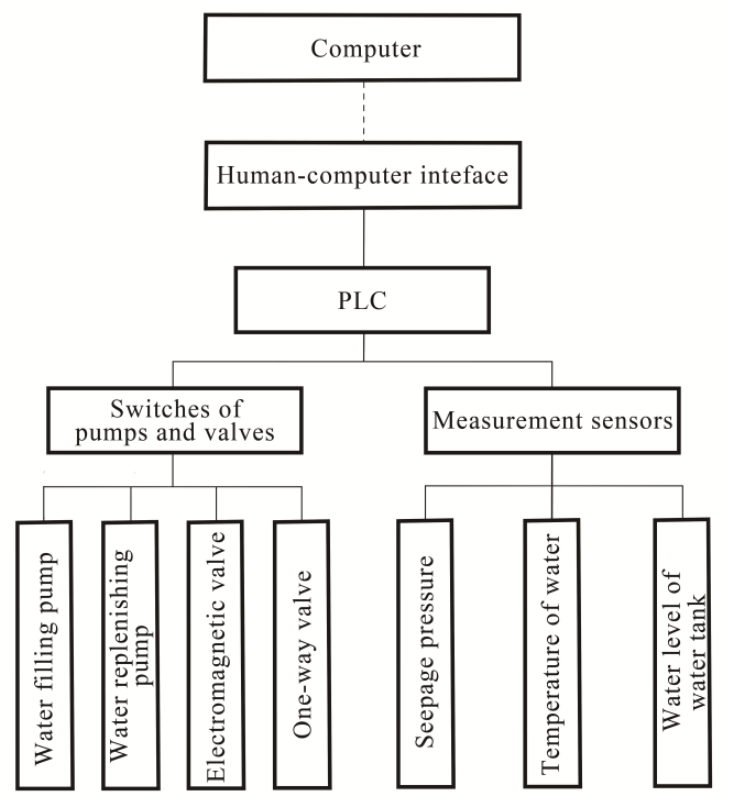
Figure 3. Topology diagram of the simple fully automatic testing method of seepage indices for low-permeability materials.